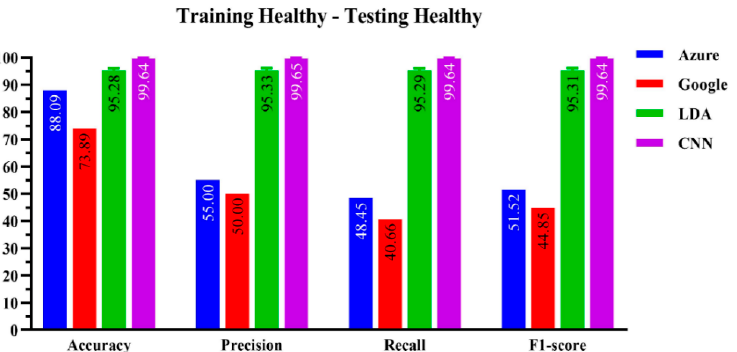
Figure 2. Performance evaluation of the four-machine learning-based algorithms on the healthy subjects’ dataset.